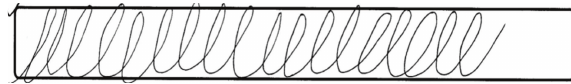
Figure 2: Example of raw data from handwriting task from an individual trial showing a rectangular box of 0.79 by 8 inches; participants were instructed to match the height of their loops to the size of the